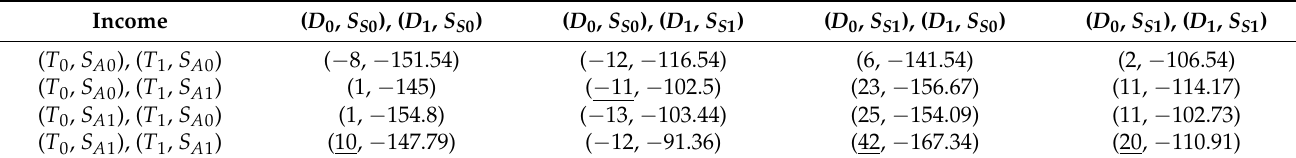
Table 9. Income Matrix of Both Offense and